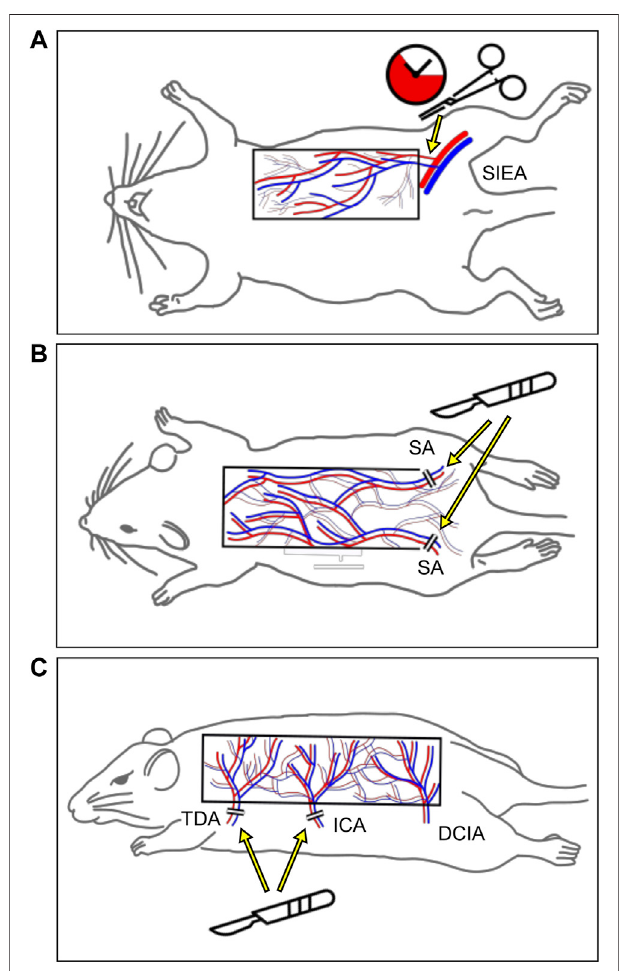
FIGURE 2 | Schematic of the three most frequently used animal fl ap models. (A) The super fi cial inferior epigastric artery fl ap enables the transient interruption of the blood fl ow into the fl ap with a clap. (B) The random pattern “ McFarlane ” fl ap is designed on the dorsum ofthe animal. In the majority of studies, the fl ap base is located caudally and both sacral arteries (SAs) are ligated to ensure distal fl ap necrosis. (C) The more recently established multi- territory dorsal perforator fl ap includes the supply area of the thoracodorsal (TDA), intercostal (ICA), and deep circum fl ex iliac artery (DCIA). By raising the fl ap on the vascular axis of the DCIA, this model simulates the physiology of perforator fl aps.